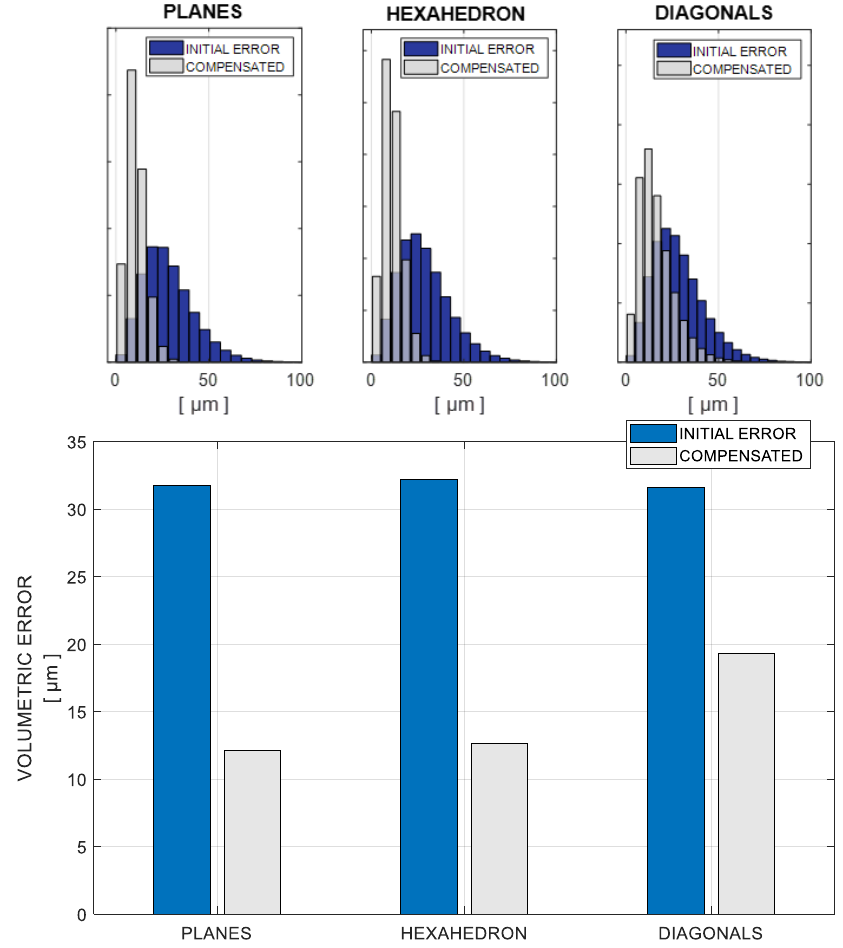
Figure 5. Comparison of measured trajectories. Error distributions and mean values are shown, for values before (blue) and after (grey) compensation.